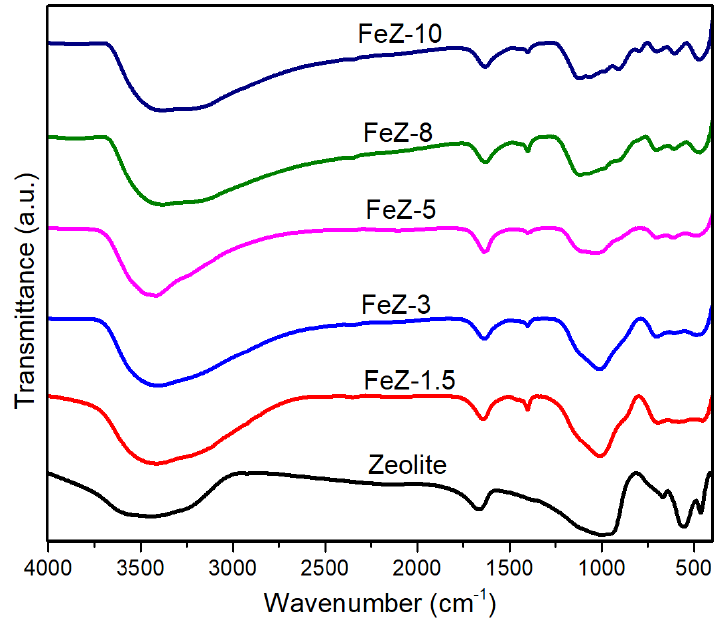
Figure 3. FTIR spectra of bare zeolite and FeZ composites.